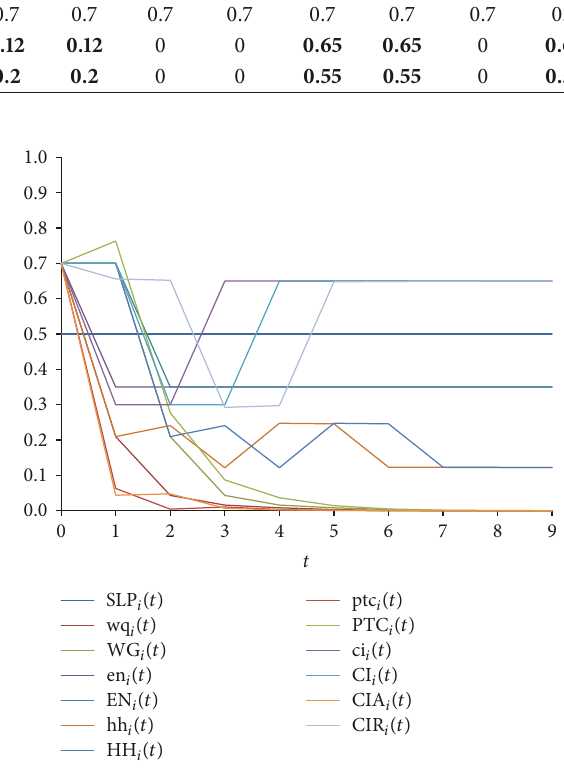
Figure 7: Dynamics of the IBN model of Drosophila seg- ment polarity genes interactions with initial state conditions 𝑋(0) = [0.5; 0.7; 0.7; 0.7; 0.7; 0.7; 0.7; 0.7; 0.7; 0.7; 0.7; 0.7; 0.7] . The IBN model reaches the point attractor in 7th iteration 𝑋(7) =